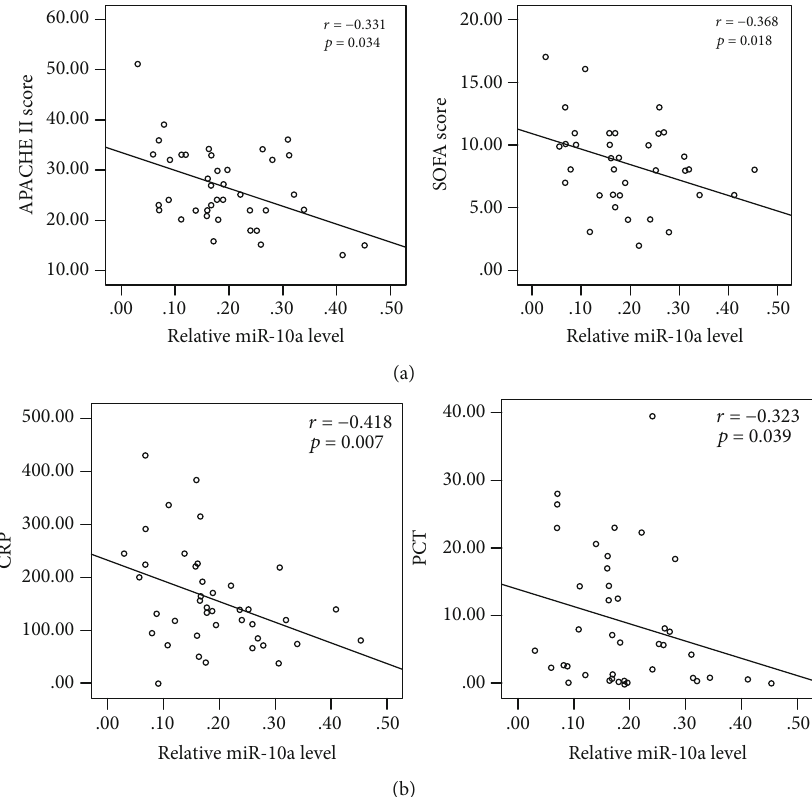
Figure 2: Correlation analysis of PBMC miR-10a levels with disease severity scores and sepsis biomarkers. (a) The curve was plotted by miR- 10a relative expression values at admission of 41 sepsis patients to their respective APACHE II and SOFA scores. (b) The curve was plotted by miR-10a relative expression levels at admission to their respective CRP and PCT values. Each circle represents an individual patient.